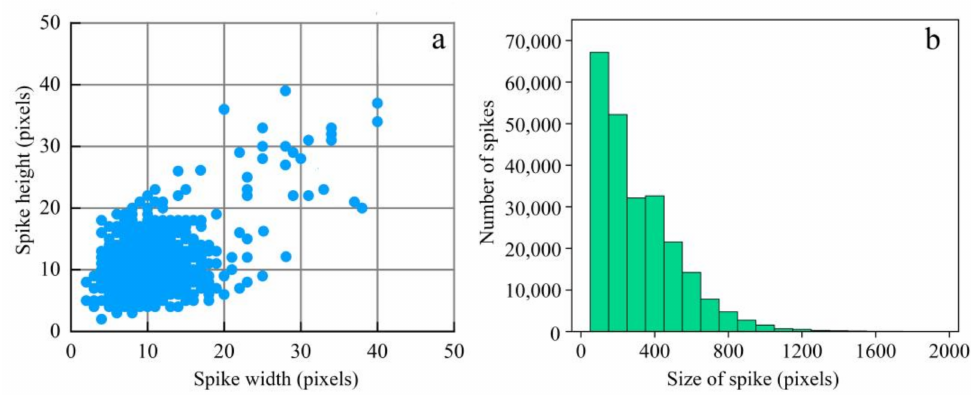
Figure 7. The size distribution of wheat spikes in UAV images. The size distribution of spike length and width ( a ). The number distribution of spikes with different sizes ( b ).